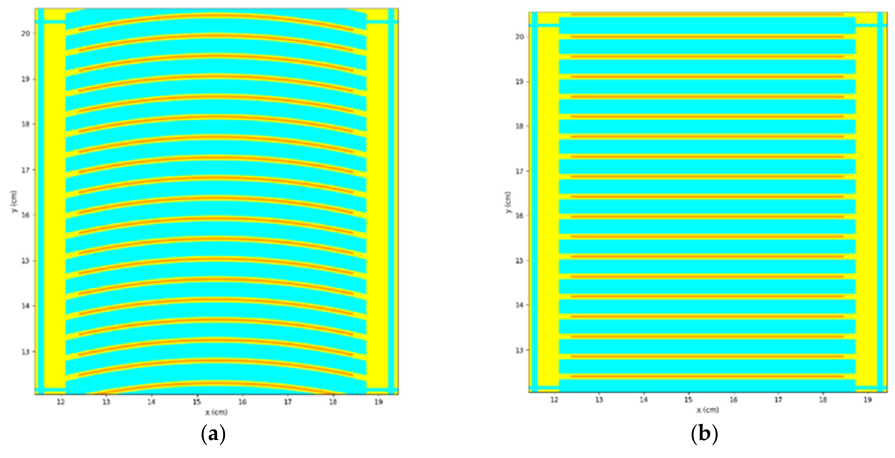
Figure 9. Top view of ( a ) curved fuel plates and ( b ) fl at fuel plates.